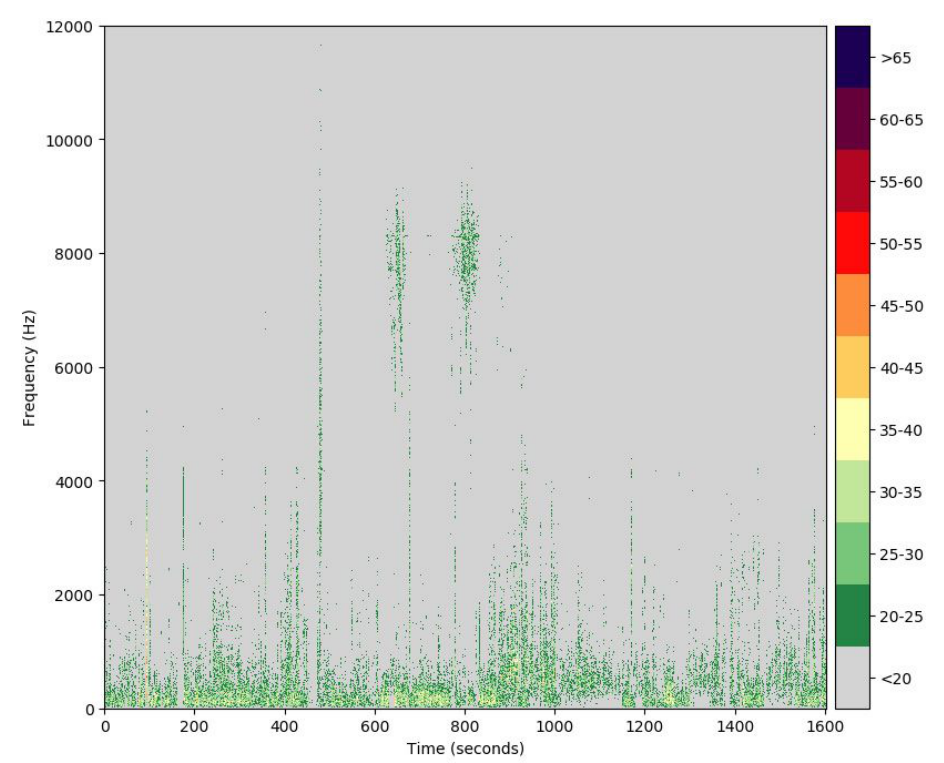
Figure 12: Spectrogram of the soundscape for round trip from Kumatakasha to the